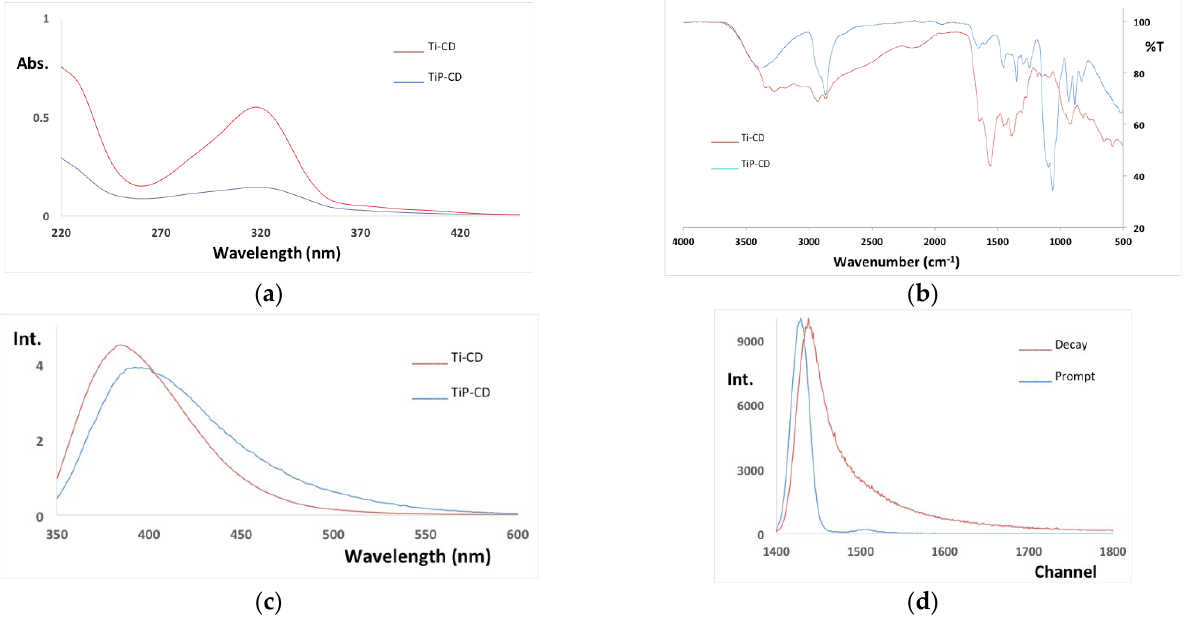
Figure 7. ( a ) UV–Vis, ( b ) FTIR, ( c ) fluorescence emission (ex. 350 nm) spectra of Ti-CD and TiP-CD, and ( d ) fluorescence lifetime decay.